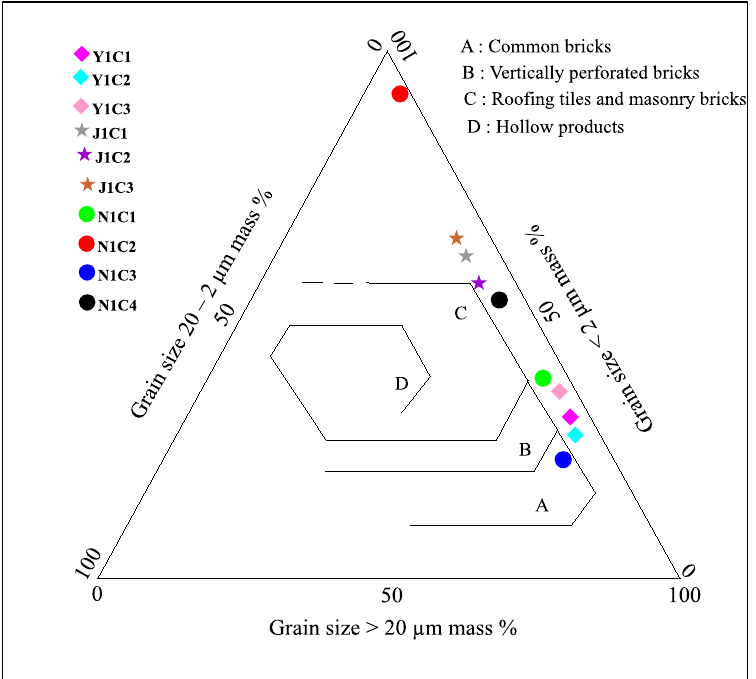
Figure 12. Suitability of the studied clayey materials according to the Winkler ternary diagram